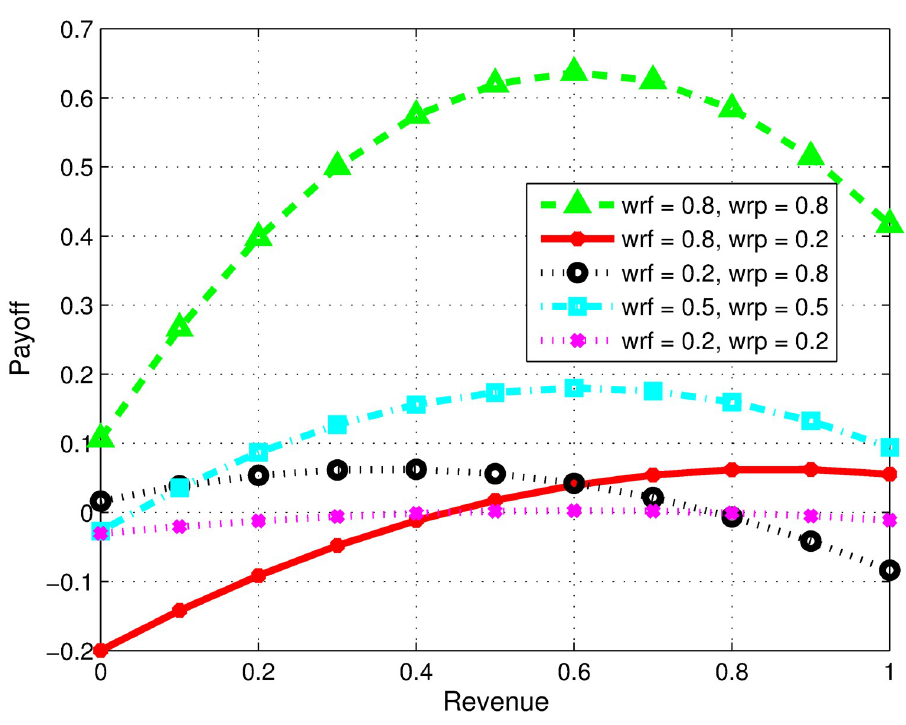
Fig 1. Impact of variation in preferences of